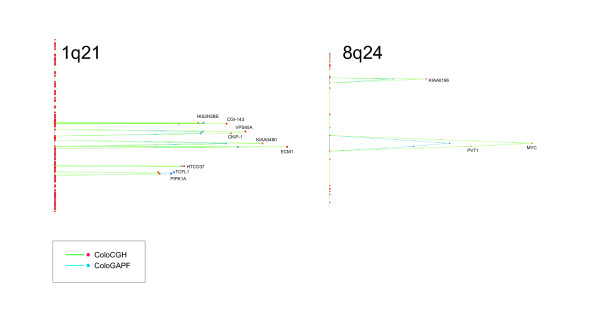
Plotting experimental data from study on a genome-wide analysis of palindrome prevalence using STRIPE. Two sets of data deriving from GAPF- and CGH-based arrays are plotted as line plots, one over the other. GAPF and CGH-based profiles of two selected regions (1q21 and 8q24) are shown in the figure. The Colo-CGH dataset is shown in green lines and with the genes as red, while the Colo-GAPF dataset is plotted with blue lines and blue spots as genes. The numerical values of the data are scaled along the horizontal axis.